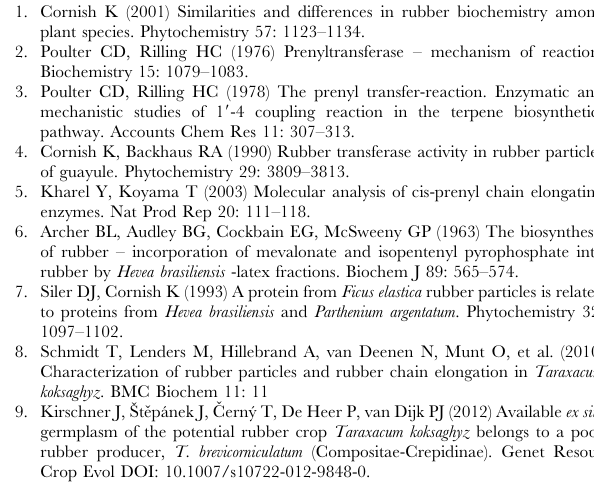
S1 Identification of TbSRPP2, TbSRPP3, TbSRPP4, and TbSRPP5 on T. brevicorniculatum rub- ber particles by mass spectrometric analysis. Table S2 Oligonucleotide sequences and respective assignments. (DOC) Text S1 Materials and Methods section regarding experiments performed for Figure